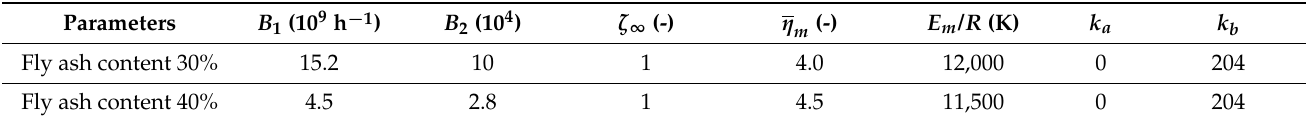
Table 5. Parameters for describing the MgO hydration properties.